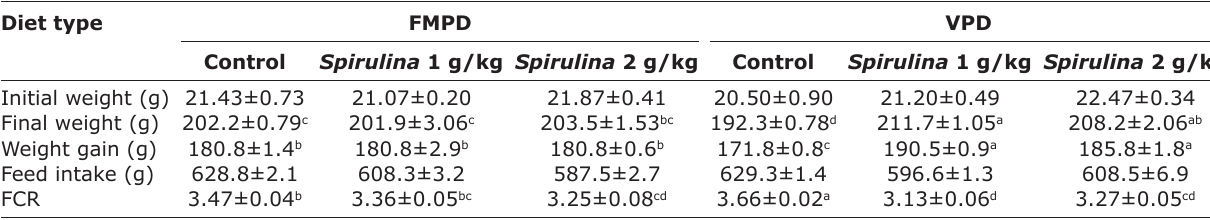
Table-3: Initial weight, final weight, body weight gain (g) and FCR of experimental groups. Diet type